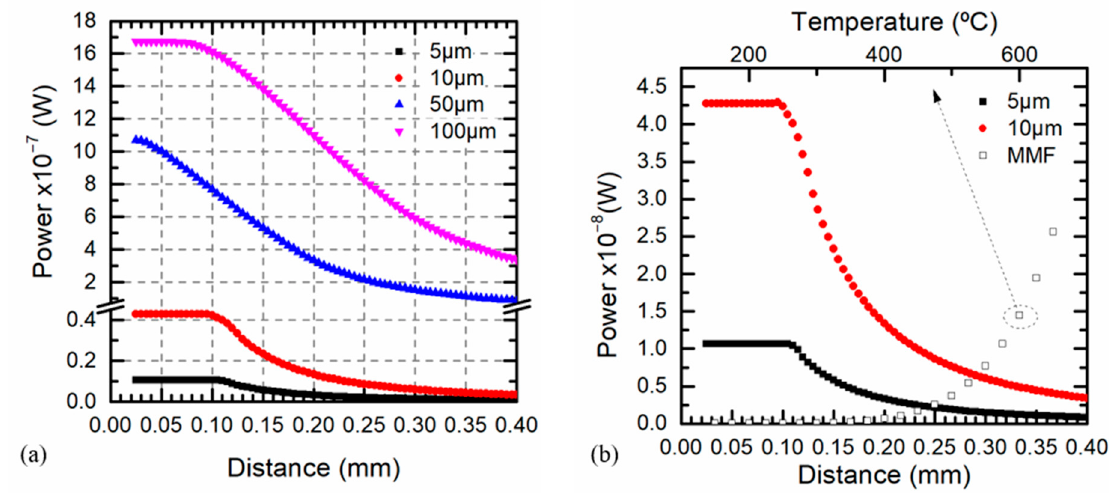
Figure 9. ( a ) Pyrometer optical power at 1550 nm versus the target-fiber distance for different target sizes at 1000 °C (black squares) 5 μ m, (red dots) 10 μ m, (blue △ triangles) 50 μ m, (pink ▽ triangles) 100 μ m. ( b ) Pyrometer optical power at 1550 nm versus distance (filled markers) at a constant temperature of 1000 °C for different target sizes and versus temperature (unfilled markers) at a constant distance of 0.3 mm for an infinite surface.